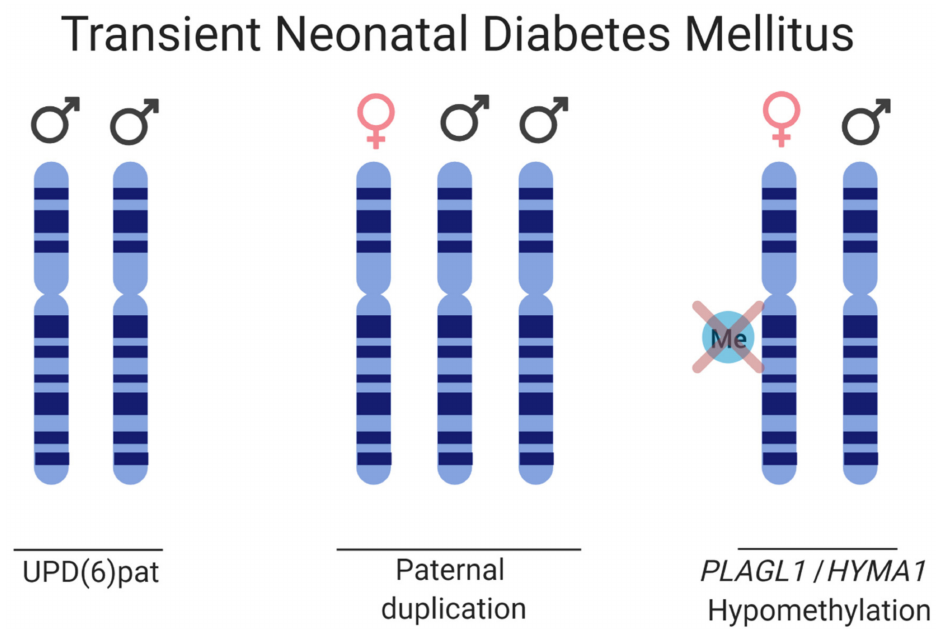
Figure 5. Schematic of the disease causes for TNDM. Three etiologies are depicted, paternal UPD of chromosome 6, paternal duplication of chromosome 6, and hypomethylation on the maternal HYMA1 / PLAGL1 promoter, thus allowing for biallelic